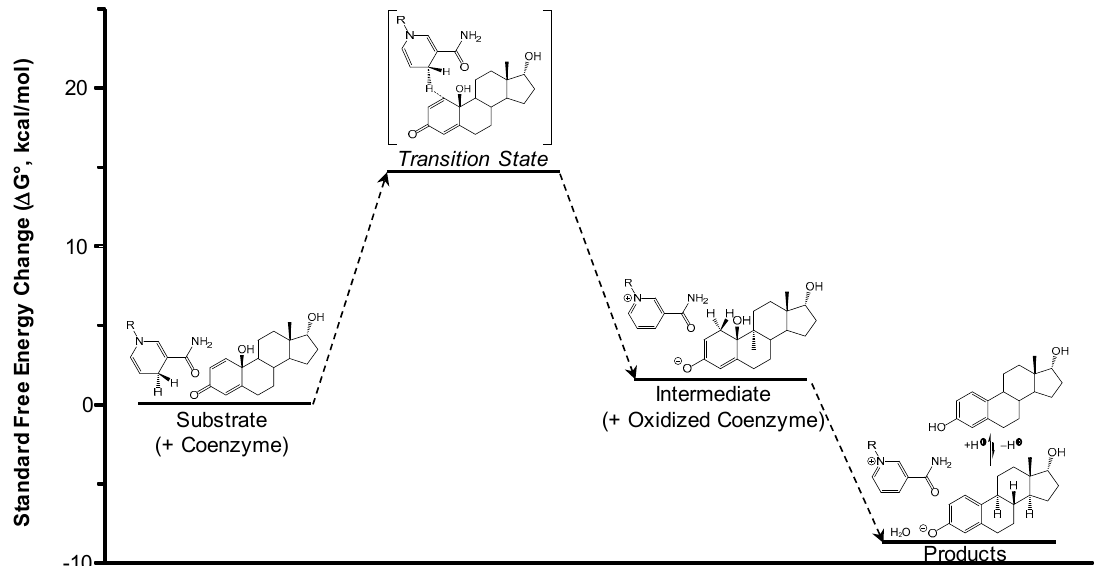
Figure 4. A mechanistic model for α DHED’s bioactivation to α E2. Semi-empirical quantum-chemical calculations (PM7 parametrization) were applied to the complete prodrug structures and a mimic of NAD(P)H ⇌ NAD(P) + (R = CH 3 ), and simulating solvation with water through the conductor-like screening model (COSMO). Reproduced with permission from Reference [37]; copyright American Chemical Society.